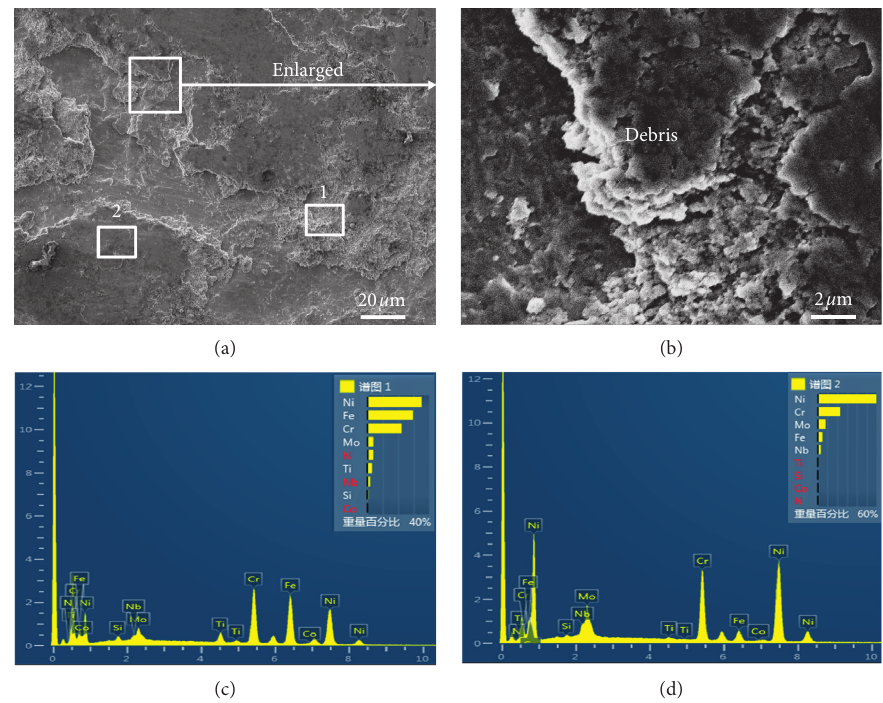
° C, 525 mm/s, 15N; (b) enlarged view of 3 N 4 grinding: (a) 25